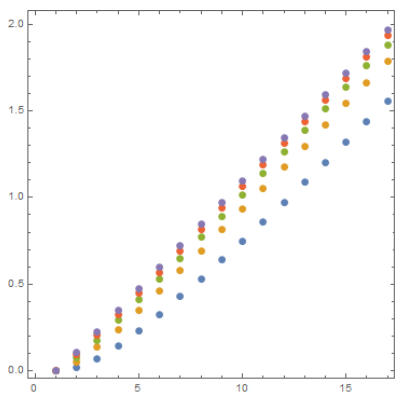
Figure 6. Plot of area for 1 ≤ p ≤ 17 and 1 ≤ k ≤ 5. Where the lowest set is the area of k = 1 and each successively higher line corresponds to the next greatest k value. The area for each p value approaches to a distinct line for each k